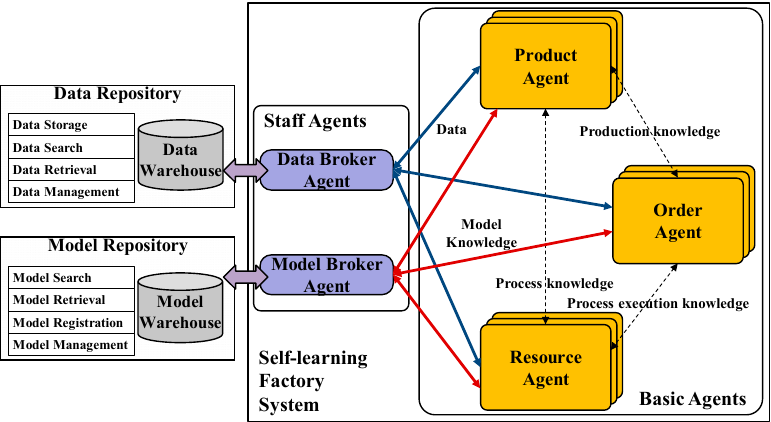
Figure 8. A system architecture for a self-learning factory.